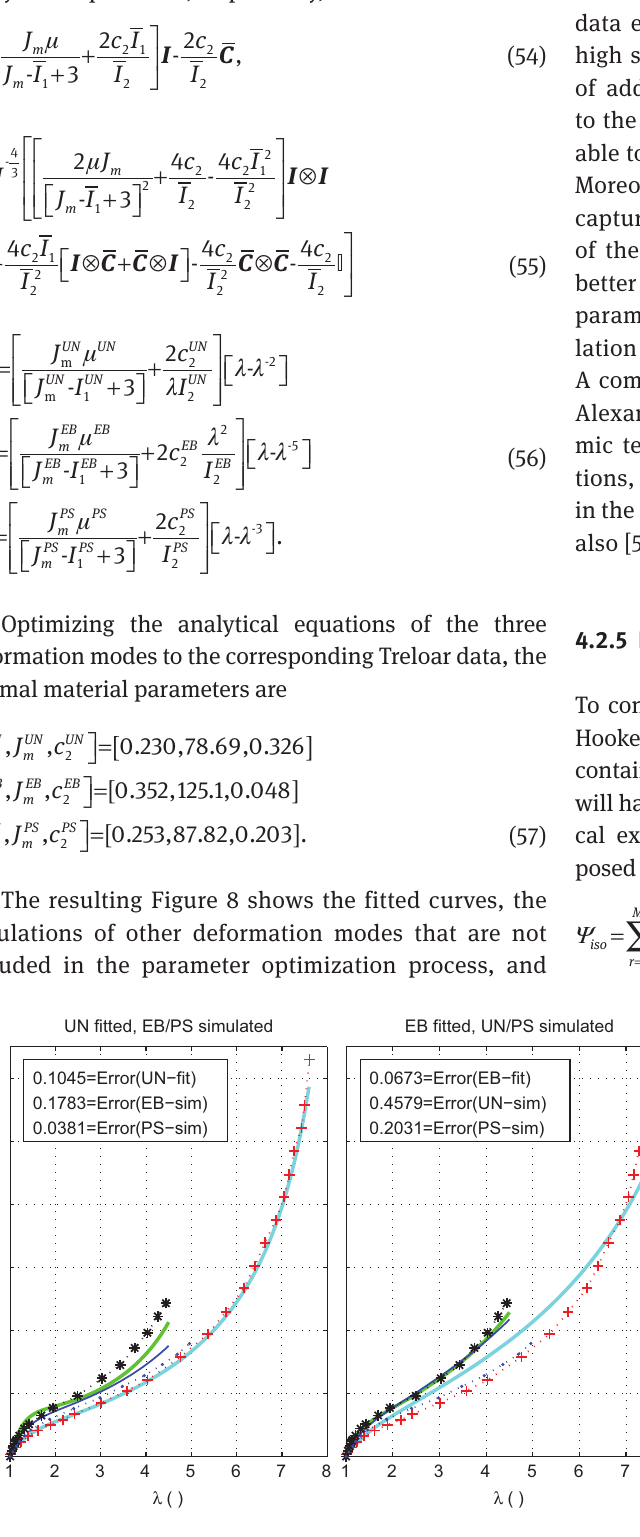
Figure 8 Performance of the Pucci-Saccomandi model on the Treloar